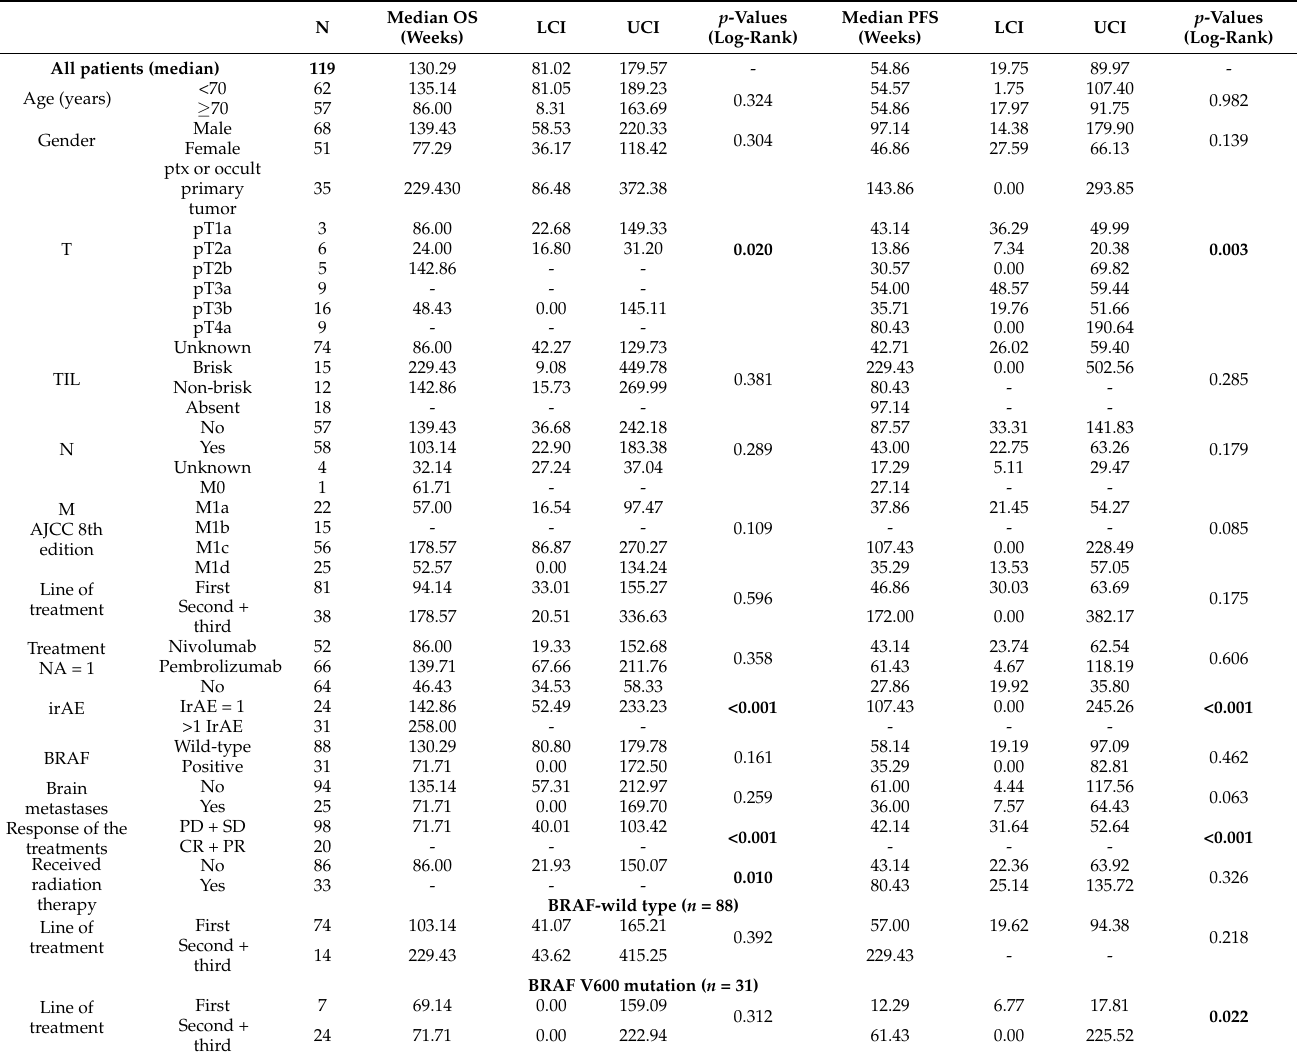
Table 4. Survival analysis of the investigated